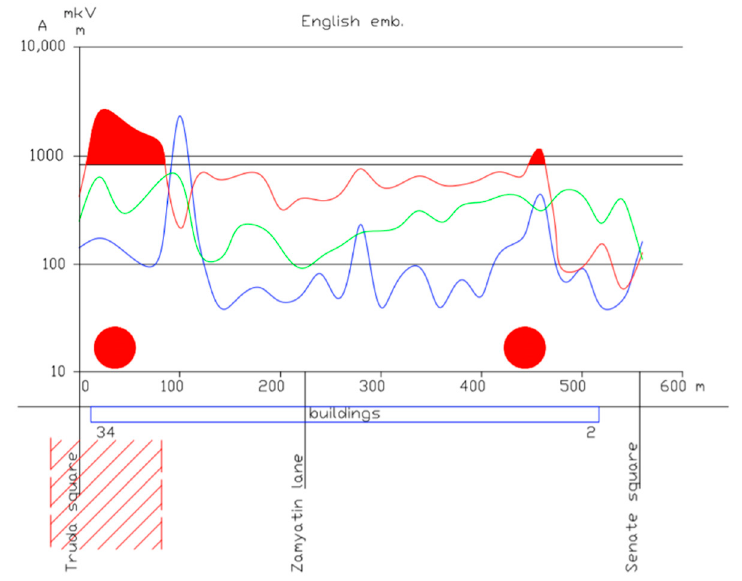
Figure 2. The results of the measurement of the ENPEMF MC along the English Embankment, Saint Petersburg, Russian Federation.